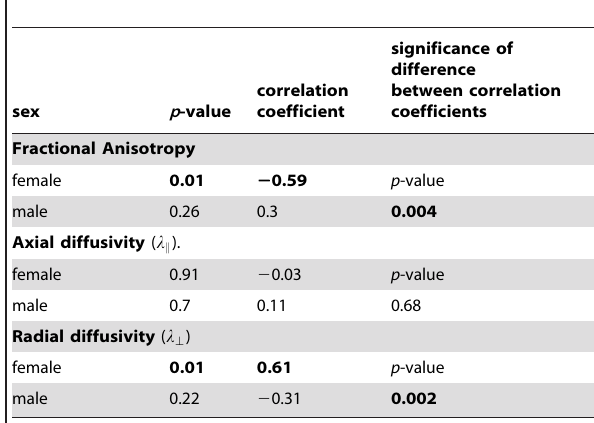
Table 1. Correlation values and permutation results for S100B, fractional anisotropy, radial and axial diffusivity in the corpus